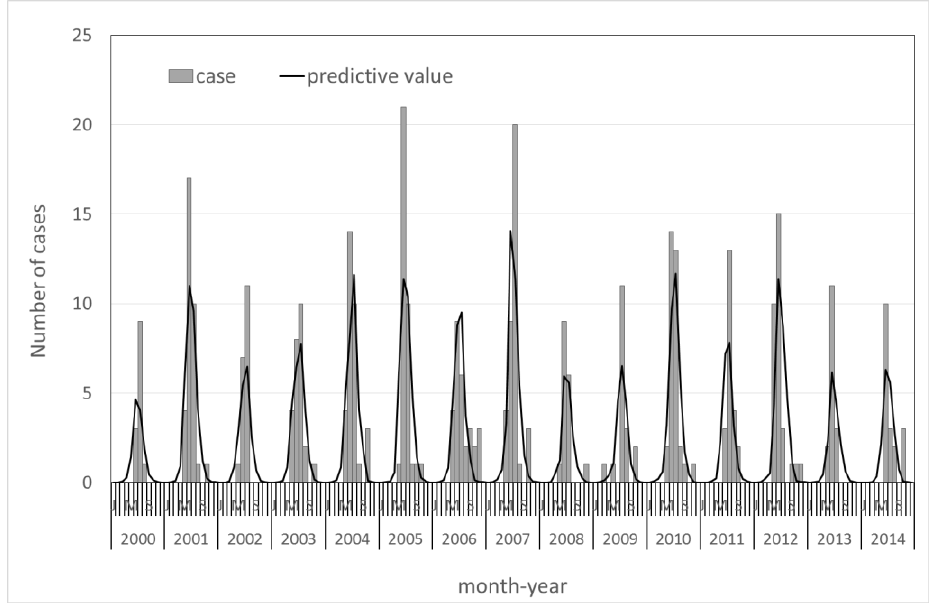
Figure 1. Trends in monthly Japanese encephalitis cases from 2000–2014 in Taiwan. Table 2. Weekly weather patterns 8–14 days prior to symptom onset and the incidence of JE virus infection in Taiwan, 2000–2014.